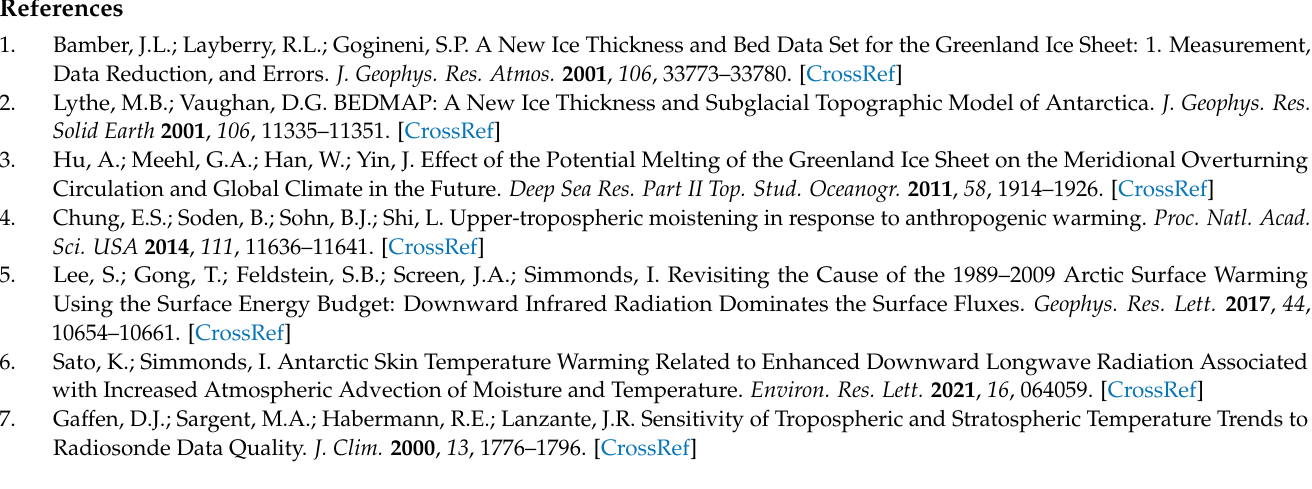
Figure A2. Ts bias and Tm bias of four reanalysis models from 2005 to 2019 at 10 stations in Green- land.